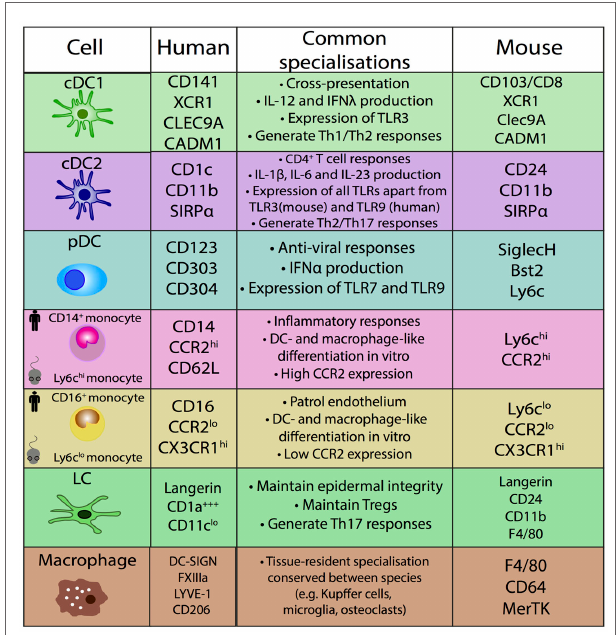
FiGURe 4 | Conserved specializations between human and mouse mononuclear phagocytes